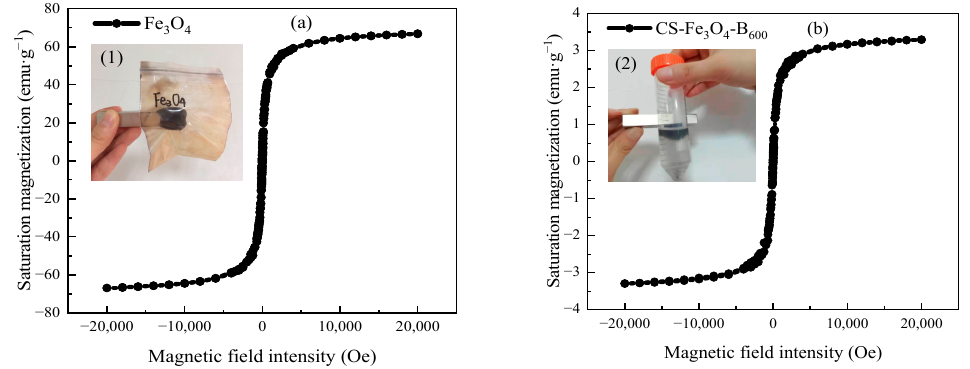
Figure 1. Hysteresis loop of Fe 3 O 4 ( a ) and Cs-Fe 3 O 4 -B 600 ( b ). Note: ( a ) shows the magnetism of Fe 3 O 4 and ( b ) exhibits the magnetic separation of Cs-Fe 3 O 4 -B 600 with a hand magnet.